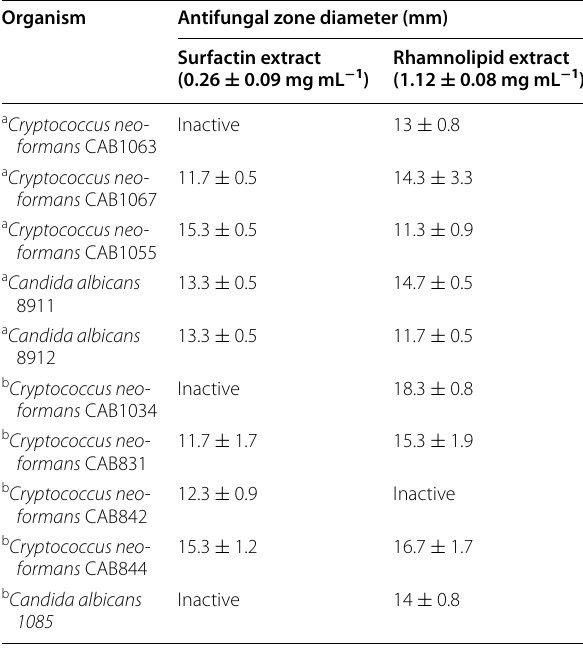
Table 2 In vitro antifungal activity of the surfactin and rhamnolipid biosurfactant extracts (1.00 mg mL − 1 ) against a panel of clinical and environmental fungal iso- lates as determined by agar disc diffusion